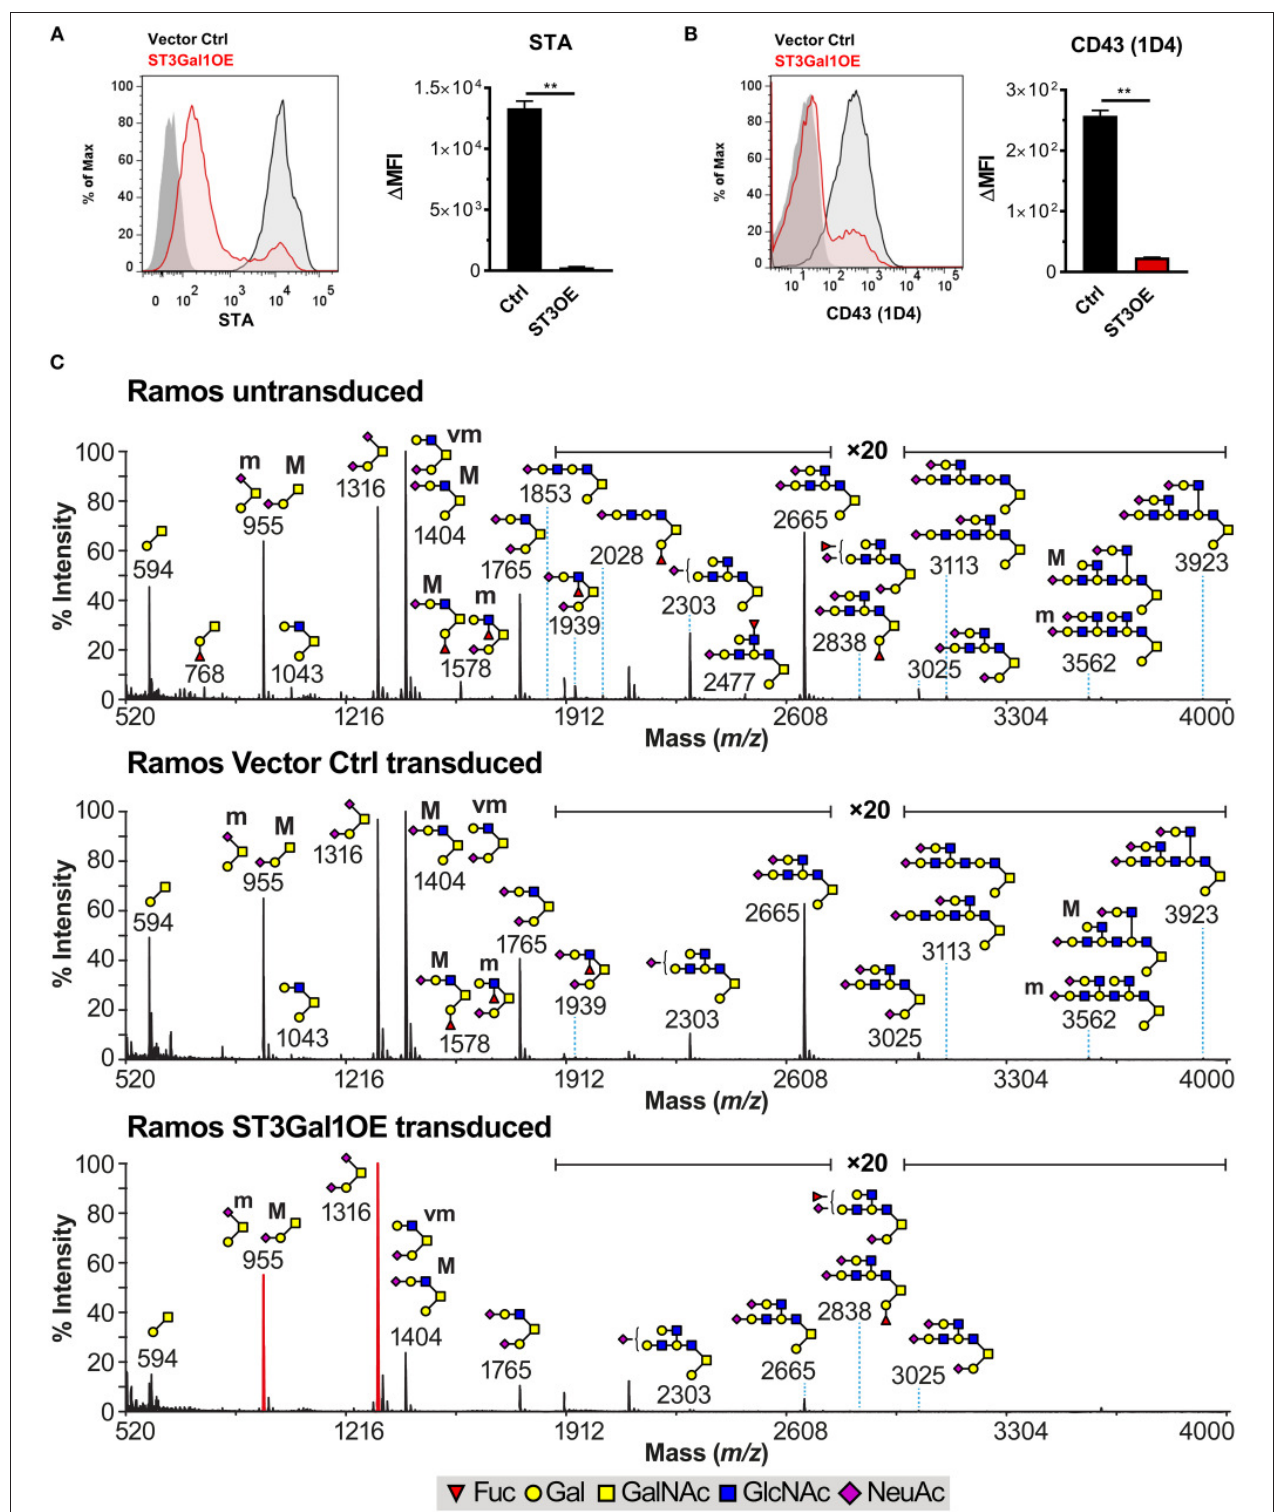
FIGURE 5 | Overexpression of ST3Gal1 truncates O-glycans in B cells. (A) Representative histograms ( left ) and quantification ( right ) of binding of the Core 2 poly-LacNAc binding lectin Solanum tuberosum agglutinin (STA) to vector control and ST3Gal1OE Ramos B cells by flow cytometry. (B) Representative